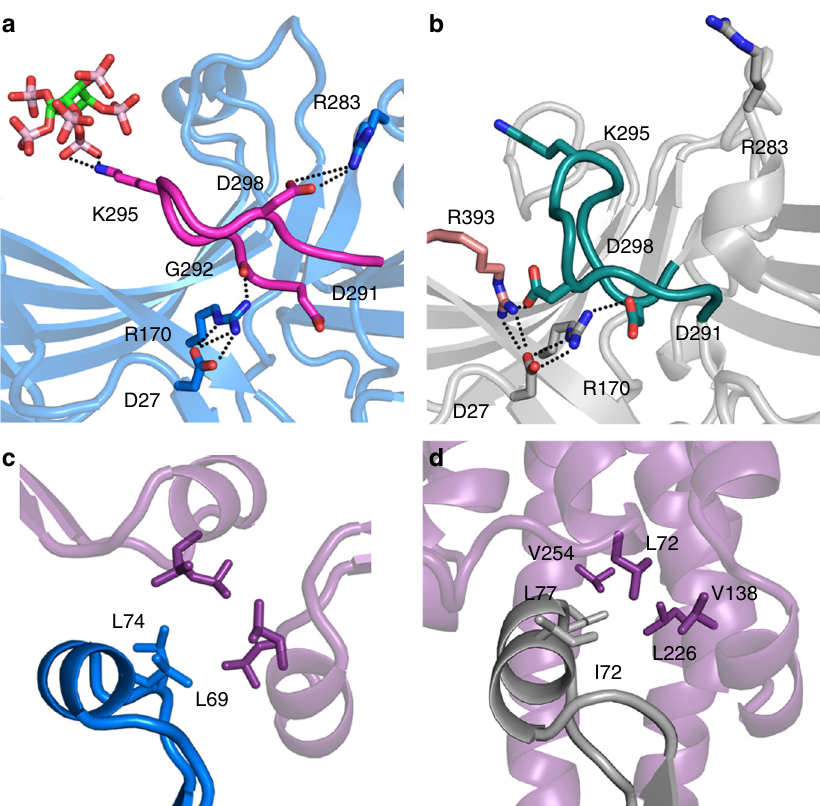
Fig. 2 The phosphate and activation sensors in IP 6 -activated arrestin-3. a Conformation of the lariat loop in IP 6 -activated arrestin-3 disrupts the polar core. b Conformation of the lariat loop in basal arrestin-3 (PDB 3P2D 6 ) with an intact polar core. c Helical conformation of the fi nger loop stabilized by the active arrestin-3 trimer. d Similar hydrophobic contacts are observed in the arrestin-1-rhodopsin interaction (4ZWJ 13 ), and have distances of 3.5 – 4 Å between hydrophobic side